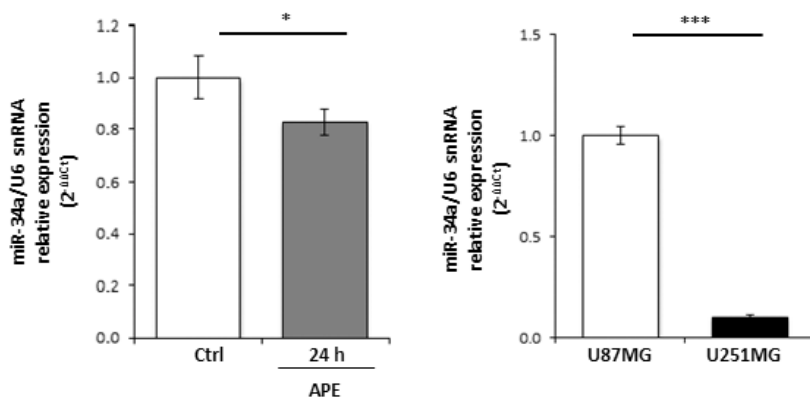
Figure A1. ( A ) Expression of miR-34-5p in GBM cell lines upon APE treatment. qRT-PCR (real time PCR analysis) expression analysis of miR-34-5p in U251MG untreated or treated for 24 h with 100 µ M APE. ( B ) Relative expression of miR-34a-5p in U251MG cells versus U87MG cells. snRNA U6 was used as the internal standard (* p < 0.05; *** p < 0.001; t -test).